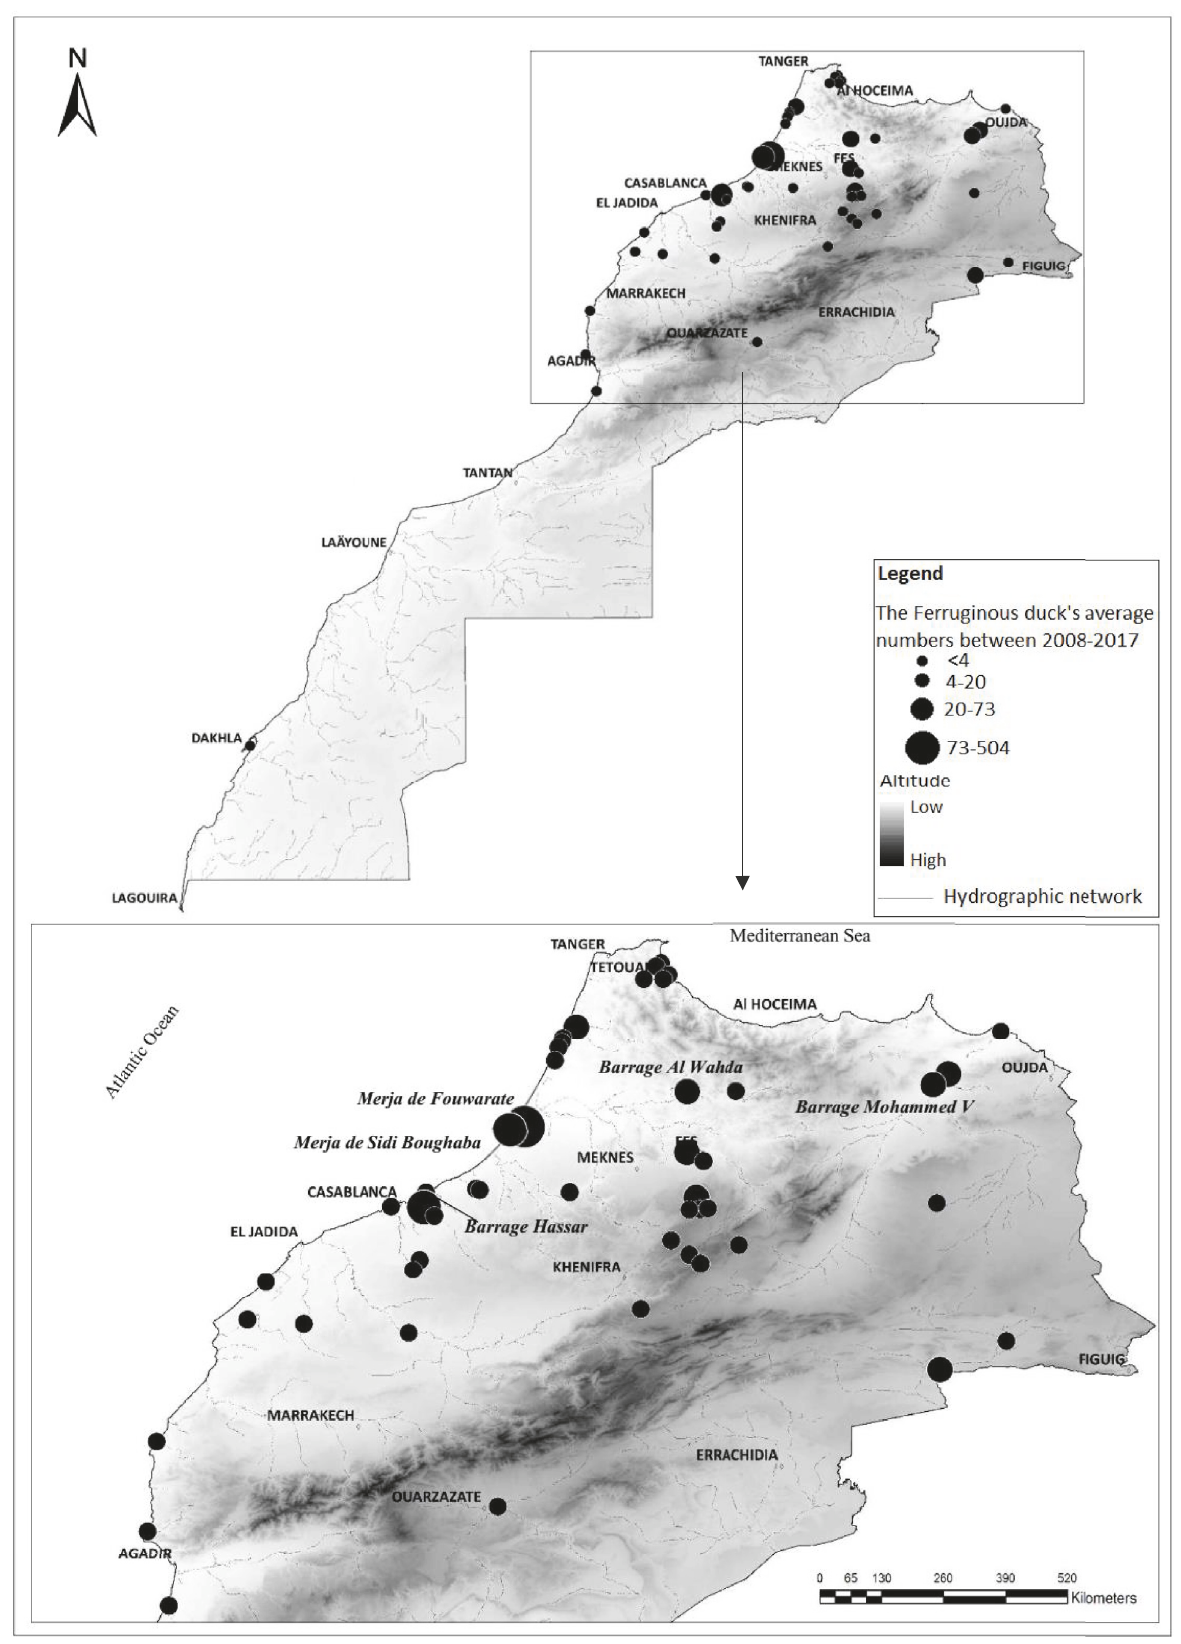
Figure 4: Distribution map of the Ferruginous duck’s wintering population in